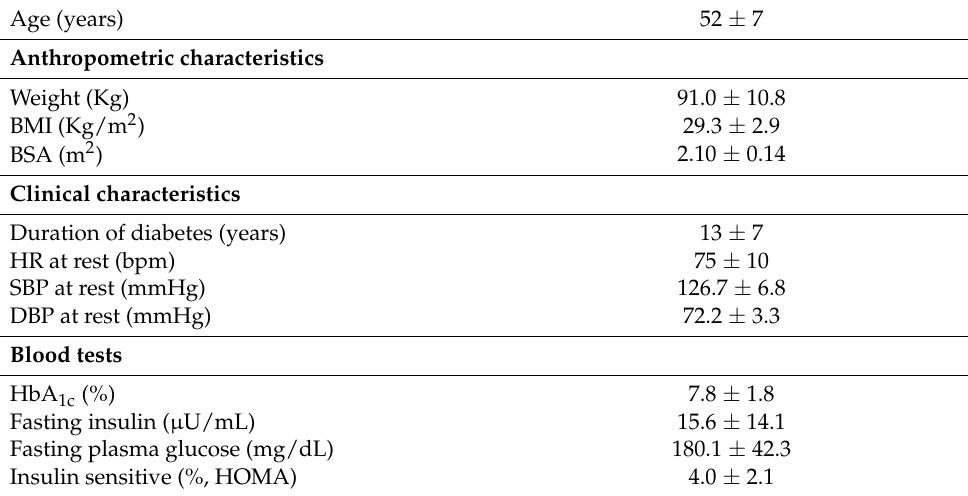
Table 2. Clinical and laboratory characteristics of the subjects ( n =